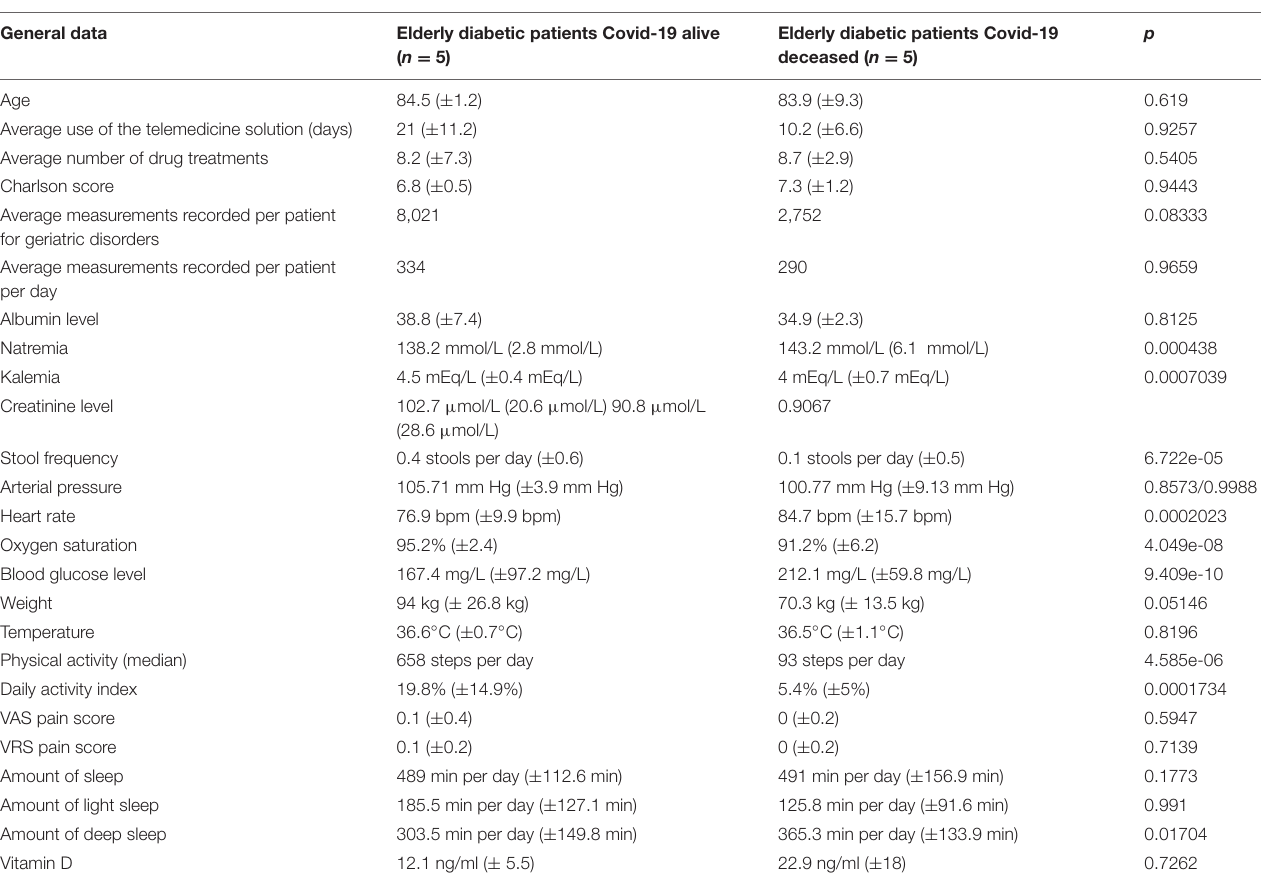
TABLE 5 | Elderly patients Covid-19 alive VS elderly patients Covid-19